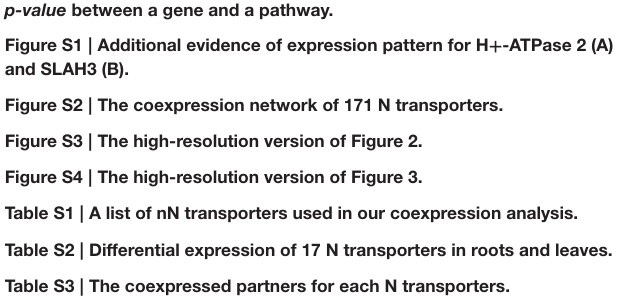
Table S5 | Functional enrichment of coexpressed genes with 171 N transporters. Table S6 | Tissue-specific coexpressed biological processes with 17 N transporters. Table S7 | All GEO datasets used in this